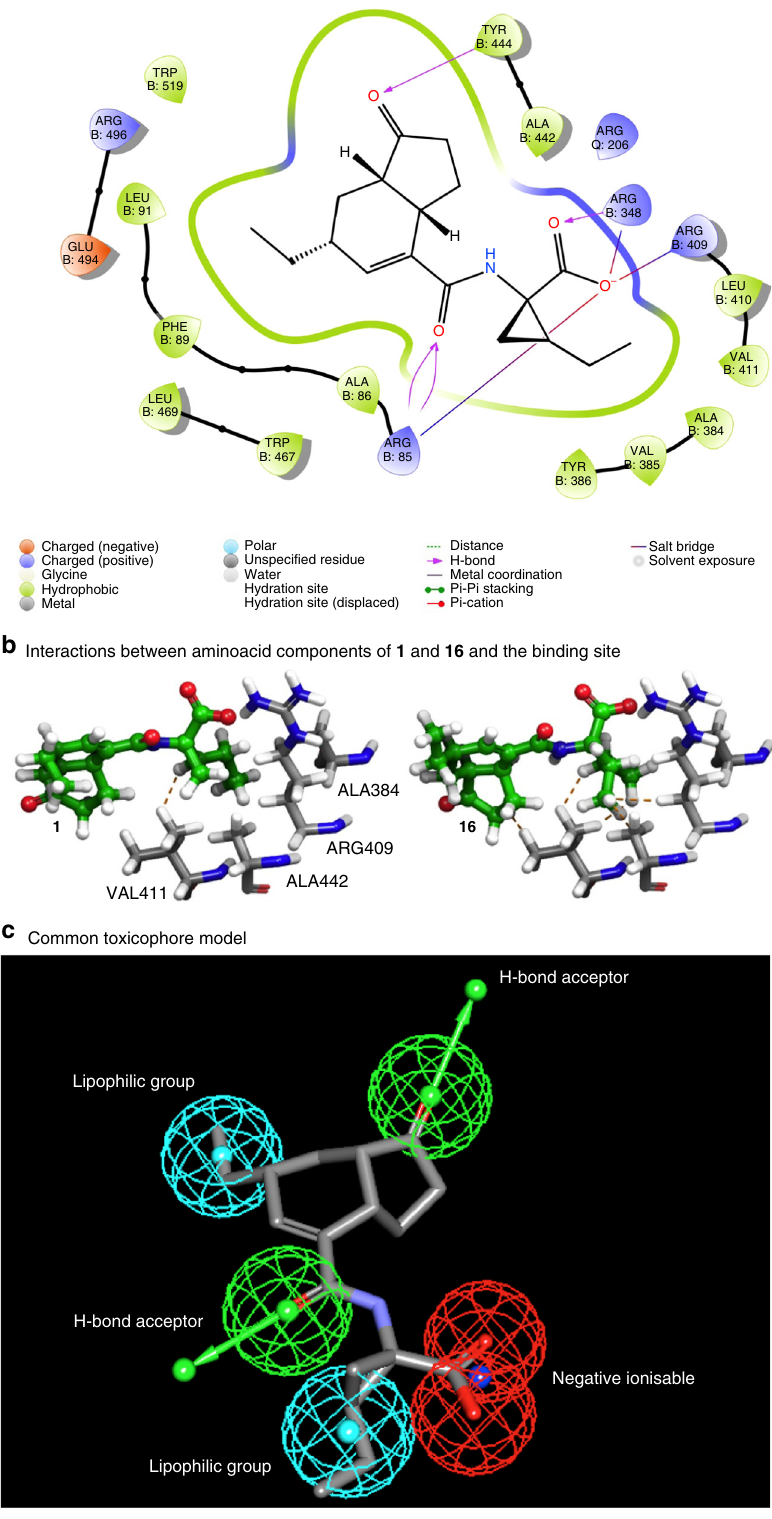
Fig. 4 Computational modelling. a COR ( 1 ) in the protein binding site (COI1) and main interactions. b Docked structures showing the interactions with 1 and 16 . Steric clashes are identi fi ed by dashed lines. c Common toxicophore